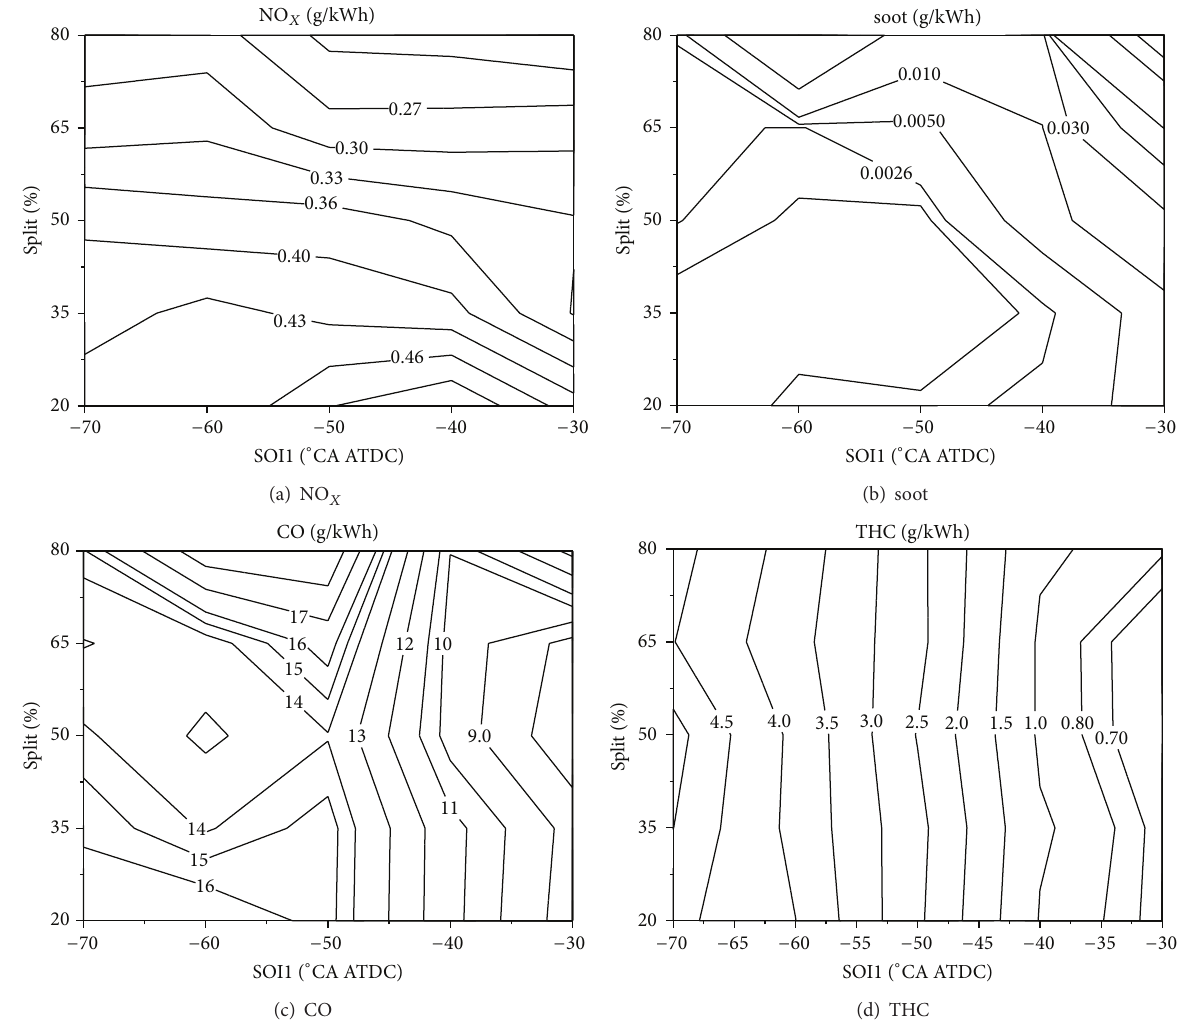
Figure 9: Emissions as a function of SOI1 and split